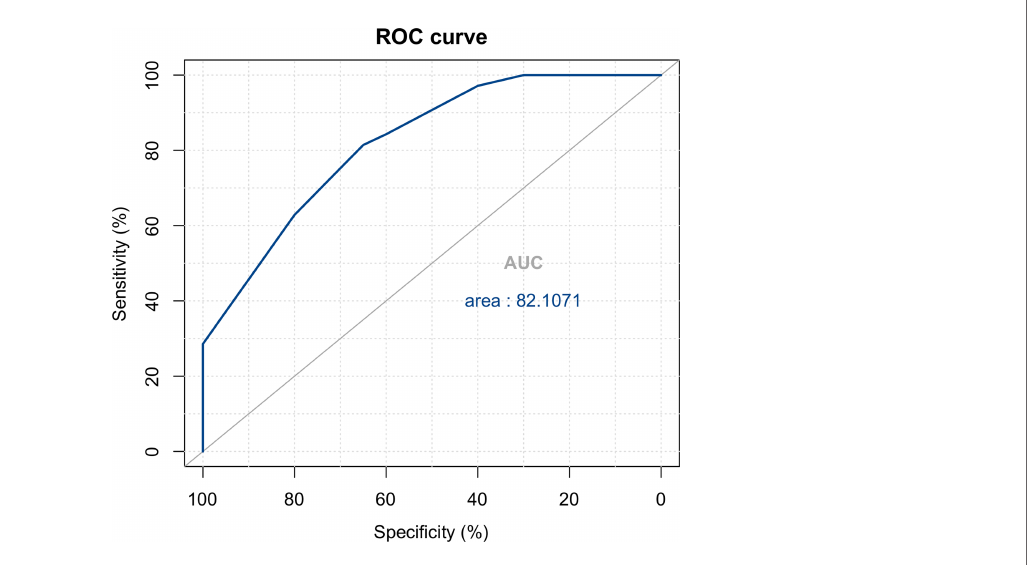
FIGURE 4 | ROC curve for the diagnostic logistic model.